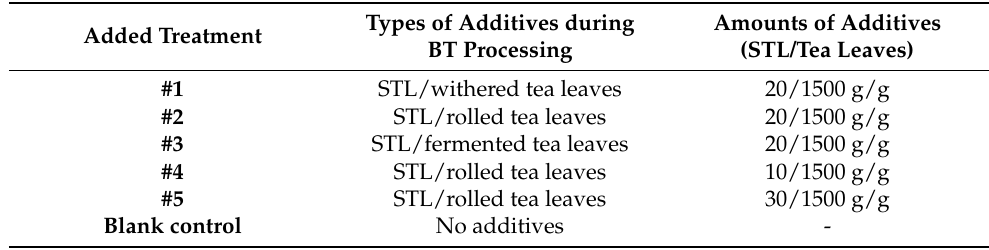
Table 1. The detailed treatments of exogenously added Strobilanthes tonkinensis Lindau (STL) leaves during black tea